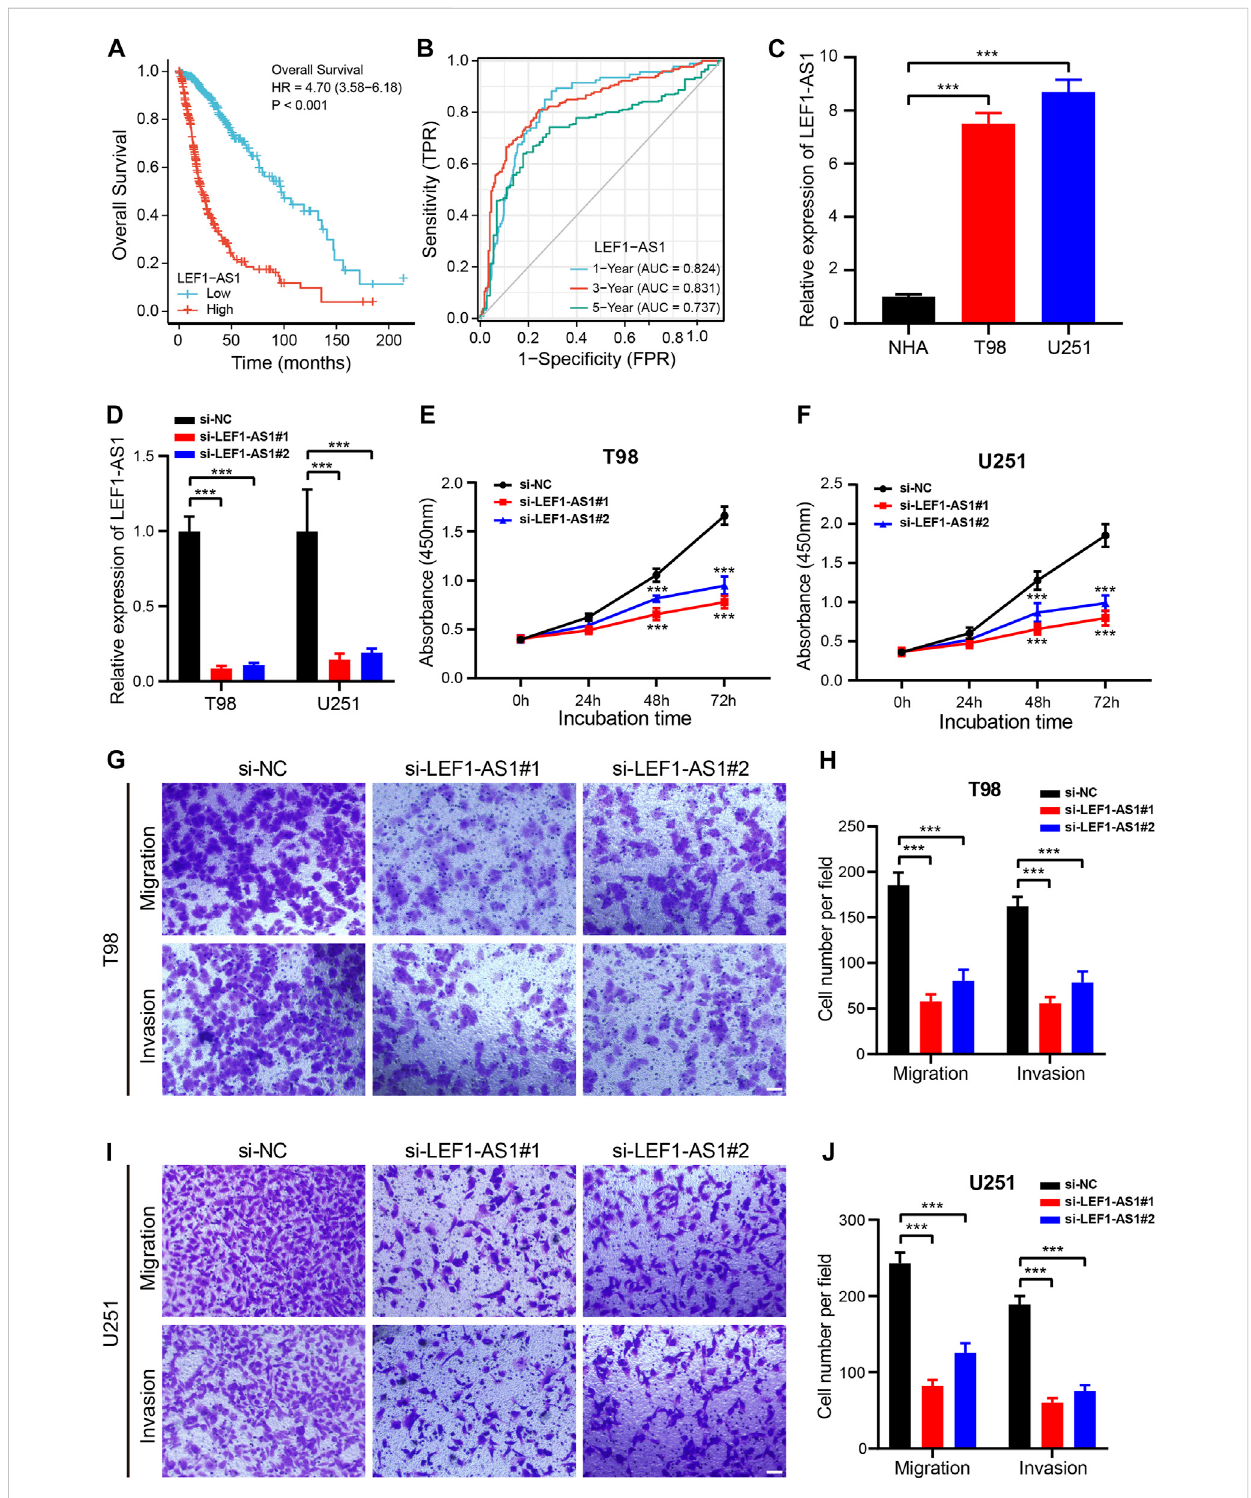
FIGURE 9 Knockdown of LEF1-AS1 inhibited cell proliferation, migration, and invasion in glioma (A) . Overall survival (OS) curves for glioma patients with high and low LEF1-AS1 expression (B) . Time-dependent ROC curves and AUC values for 1-year, 3-year, and 5-year OS prediction (C) . RT-qPCR analysis was appliedtodetect LEF1-AS1expressionintwogliomacelllines(T98andU251)andanormal humanastrocyte (NHA)cellline (D) .Theef fi ciencyofsi-LEF1- AS1transfectioninT98andU251cellswasassessedbyRT-qPCR (E – F) .CellproliferationofT98 (E) andU251 (F) cellstransfectedwithcontrol(si-NC) or si-LEF1-AS1 was measured via CCK8 assay (G – J) . Migratory and invasive capacities of LEF1-AS1-de fi cient T98 (G,H) and U251 (I,J) cells were determined using Transwell cell migration and invasion assays. Scales bar, 100 μ M. *** p <